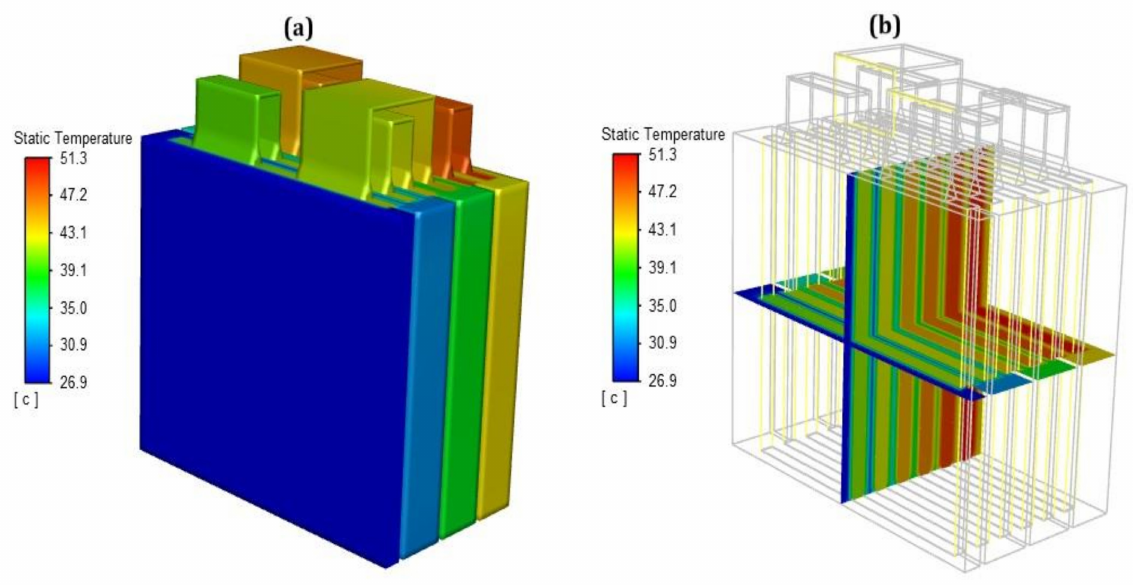
Figure 8. LIB module temperature characteristics at 3C discharge rates with air-cooling ( a ) tempera- ture distribution and ( b ) cell cross-section temperature.